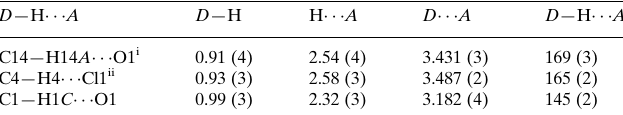
Hydrogen-bond geometry (A˚ , (cid:2)